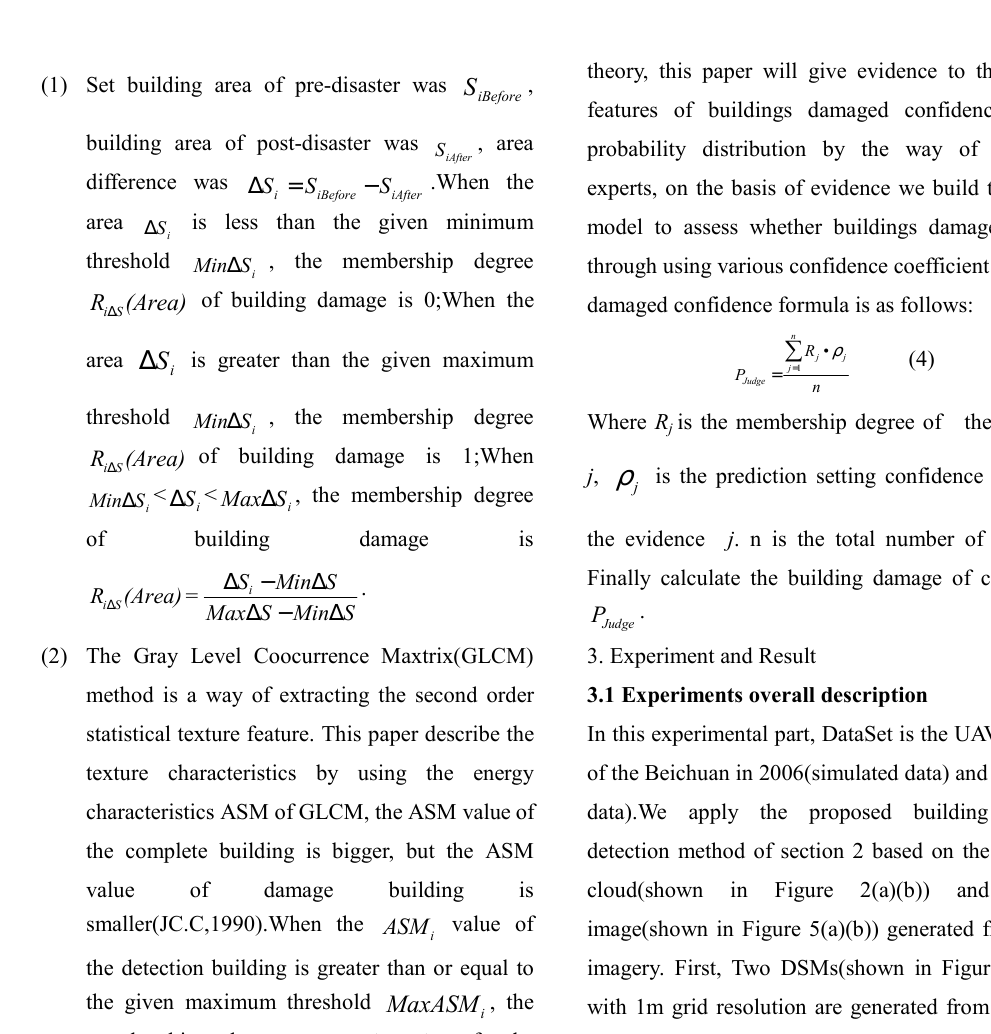
image(shown in Figure 5(a)(b)) generated from UAV imagery. First, Two DSMs(shown in Figure 4(a)(b)) with 1m grid resolution are generated from 3D point cloud of pre- and post-disaster. The difference image is generated by subtracting the pre-disaster DSM from post-disaster DSM. After Canny edge detecting and image two-values processing, the change suspect area image (shown in Figure 4(c)) is obtained. Second, building vector (shown in Figure 3) is obtained by using the method of section 2.1(2). Third, the change suspect area image is projected to the mosaic UAV image, then building vector is overlaid with the mosaic image to obtain the building position(see Figure 5(a)(b)) in the change suspect area. Finally, the damage buildings are detected by using the method of section 2.5 and